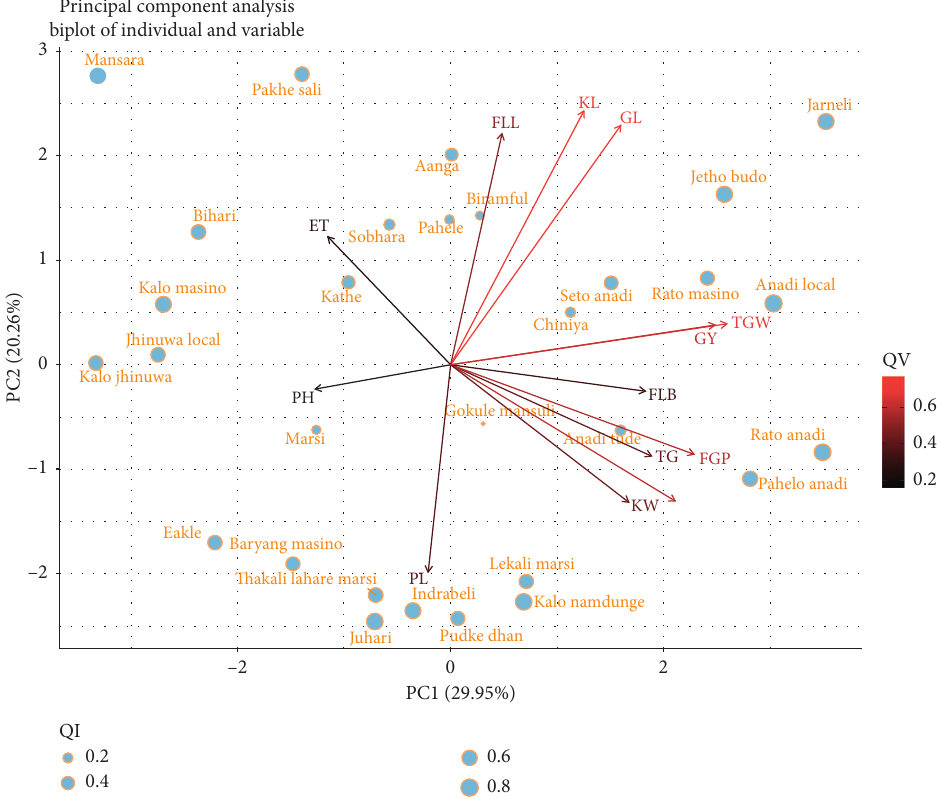
Figure 4: The biplot of 30 rice landraces for PC1 and PC2. The arrows show the contribution (magnitude and direction) of the trait in PC1 and PC2. QI is the quality of representation of individuals, and QV is the quality of representation of variables. (TG: total grain, FGP: filled grain percentage, PL: panicle length, GL: grain length, GW: grain width, KL: kernel length, KW: kernel width, FLL: flag leaf length, FLB: flag leaf breadth, ET: effective tiller, PH: plant height, TGW: thousand-grain weight, GY: grain